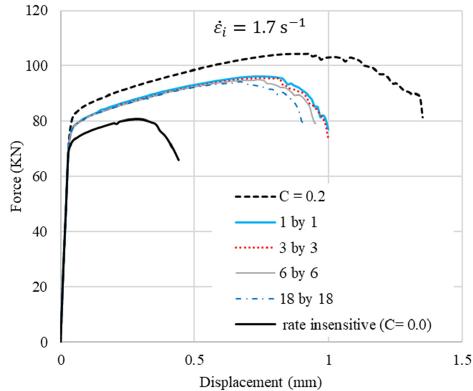
Figure 6. Sequence of crack propagation in a typical compressed ring specimen: ( a ) formation of shear bands and crack initiation at the corner of outer wall; ( b ) crack propagates along the shear bands; ( c ) crack reaches the center of the cross-section; and ( d ) crack reaches the inner wall (complete rupture). The stroke of the top platen, d , is shown above the models.